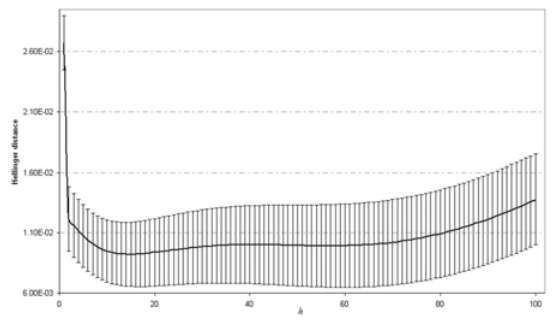
Fig. 6. Mean and standard deviation of the distance between the true PDF and its vector quantization based Parzen estimation with a fixed number of kernels (K = 300) and varying width scaling factor h.